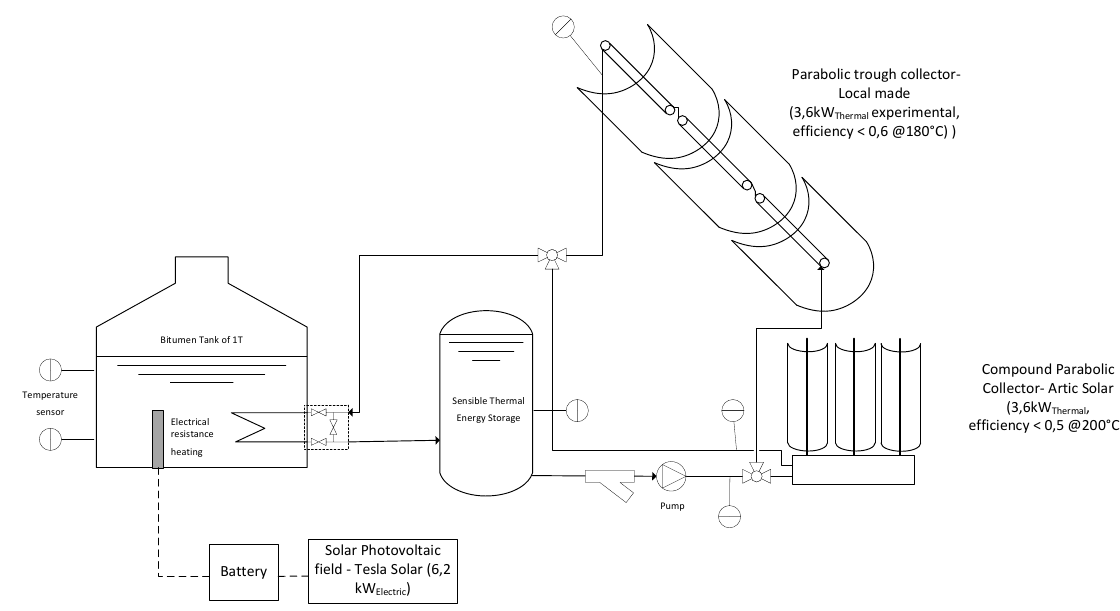
Figure 2. Piping and instrumentation diagram of the one-ton prototype .